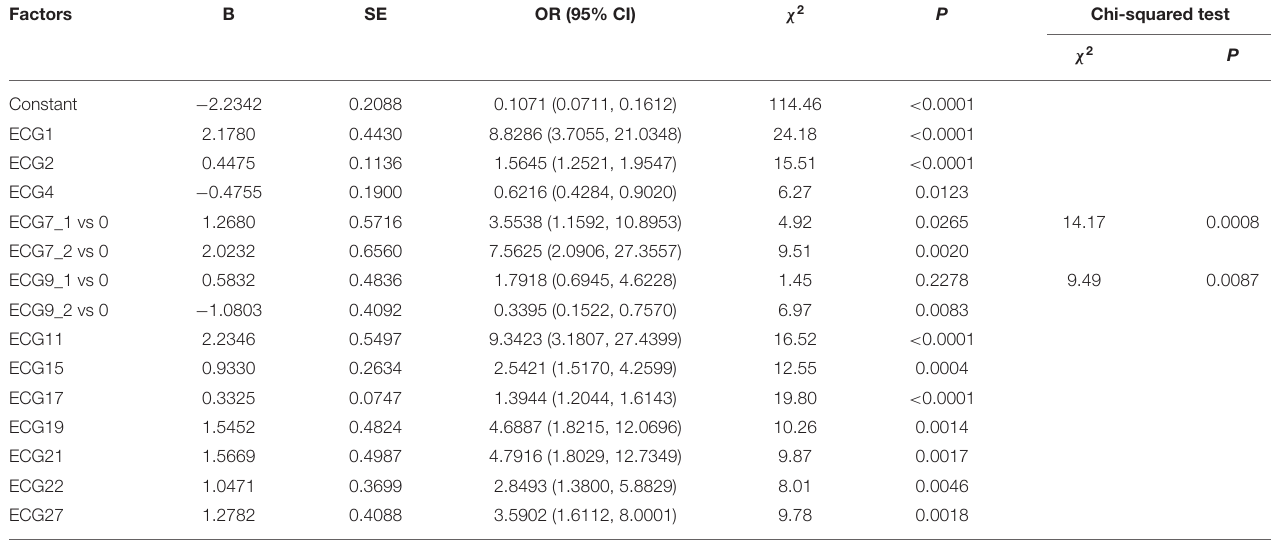
Table 3 indicates the univariate logistic regression model and the statistical associations between research factors and acPE. An ECG-predictive model was established using a forward stepwise regression and multivariate logistic regression model ( Table 4